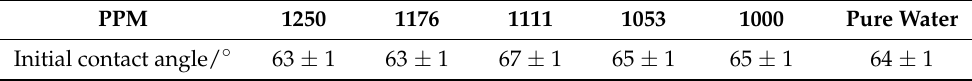
Table 2. Initial droplet contact angles of different liquids. PPM 1250 1176 1111 1053 1000 Pure Water Initial contact angle/